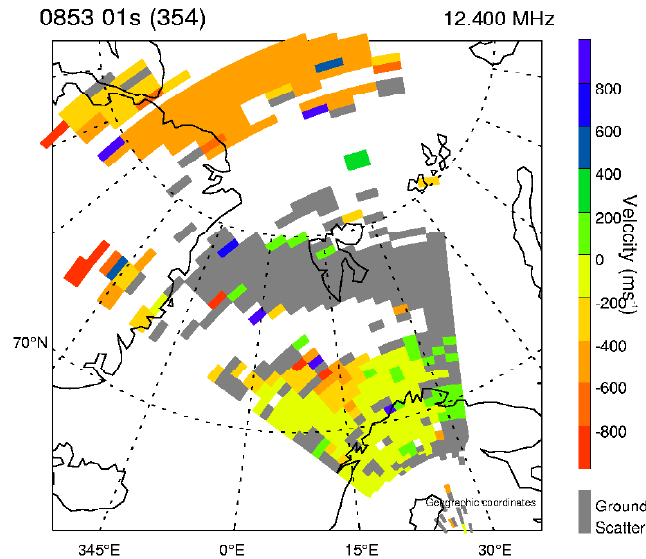
Fig. 5. Line-of-sight velocity components measured by the UK Su- perdarn radar (CUTLASS) located in Finland on a geographic co- ordinate grid at about 08:53 UT on 20 December 1998. The illus- trated flows are representative of the broader time interval of interest between 08:45 UT and 09:00